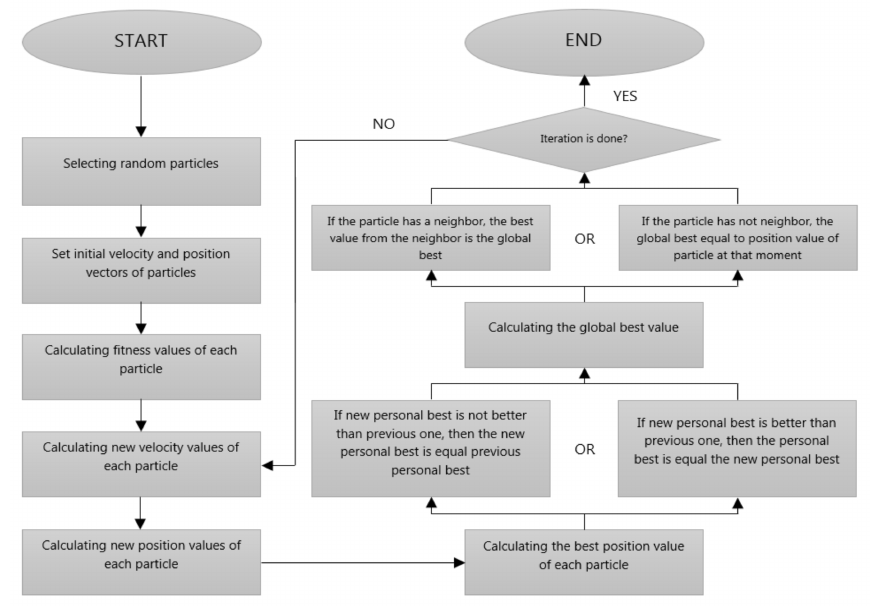
Figure 5. Flow diagram of particle swarm optimization